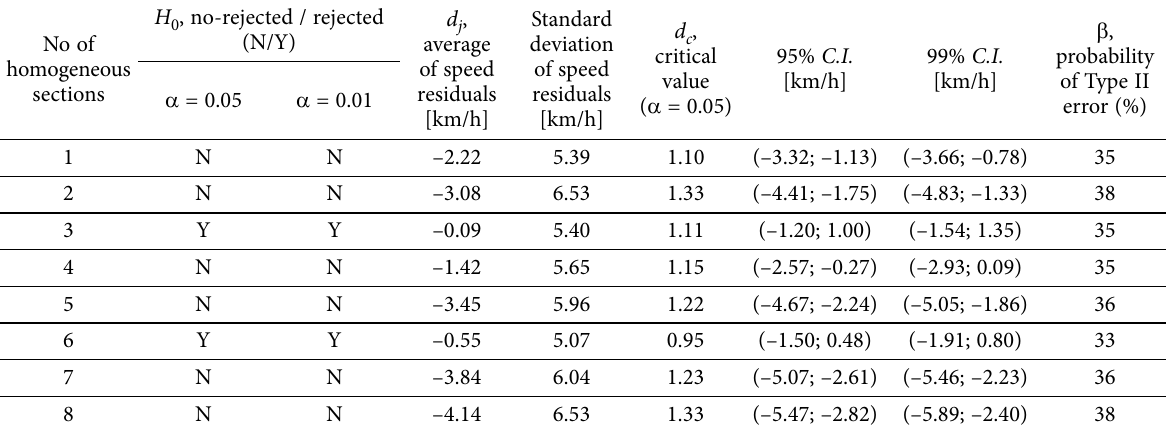
Table 2. Summary of results in all locations